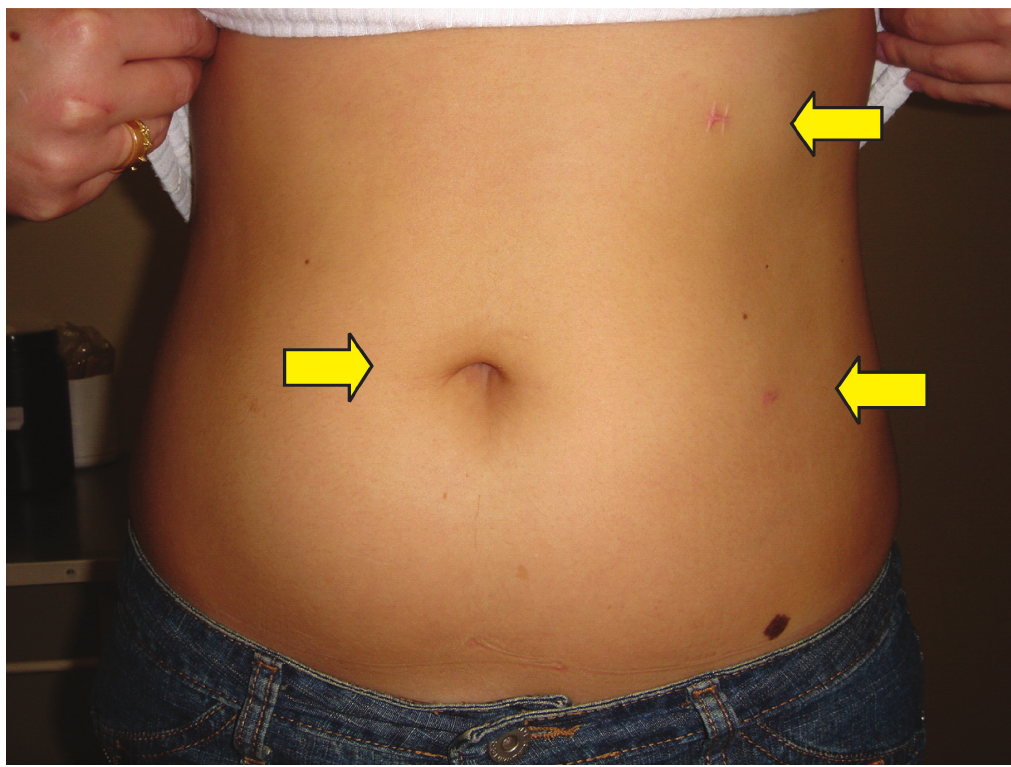
Figure 1 - Port sites demonstrated as surgical scars after left side laparoscopic